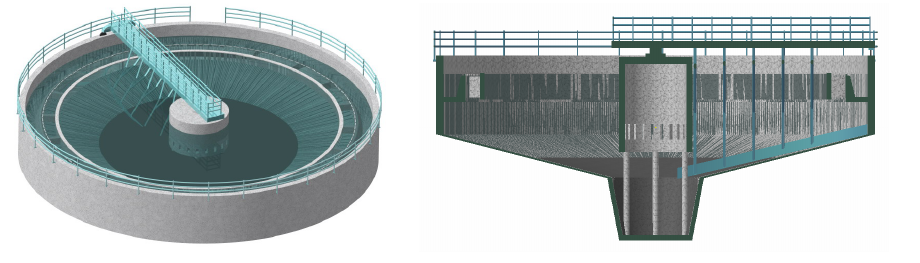
Figure 4 – 3D Model of the Primary Clarifier